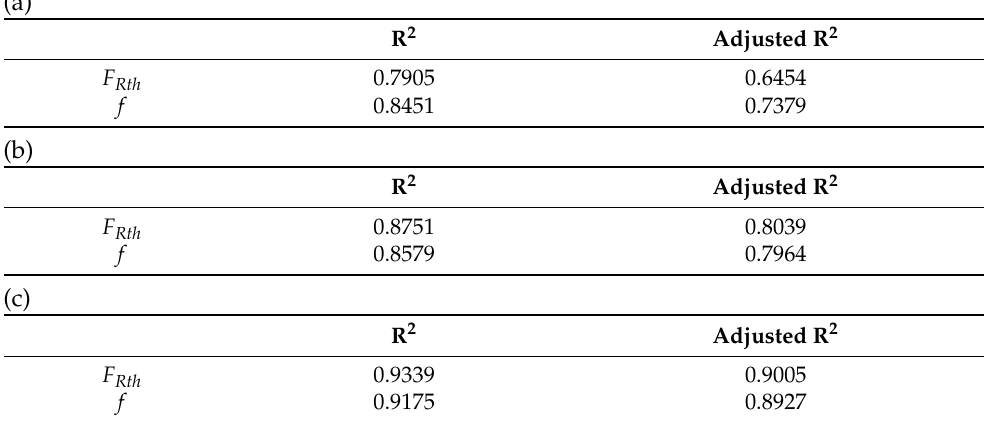
Table 6. Statistical analysis of the RSA models. (a) Full factorial design; (b) Conventional